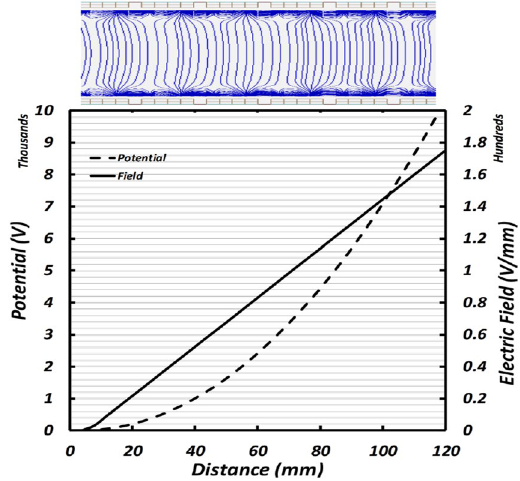
Figure 5. Top- Schematic of the IDT. Constant electric field lines are shown for convenience (blue). Bottom.- Expected axial voltage and field due to the electrodes.